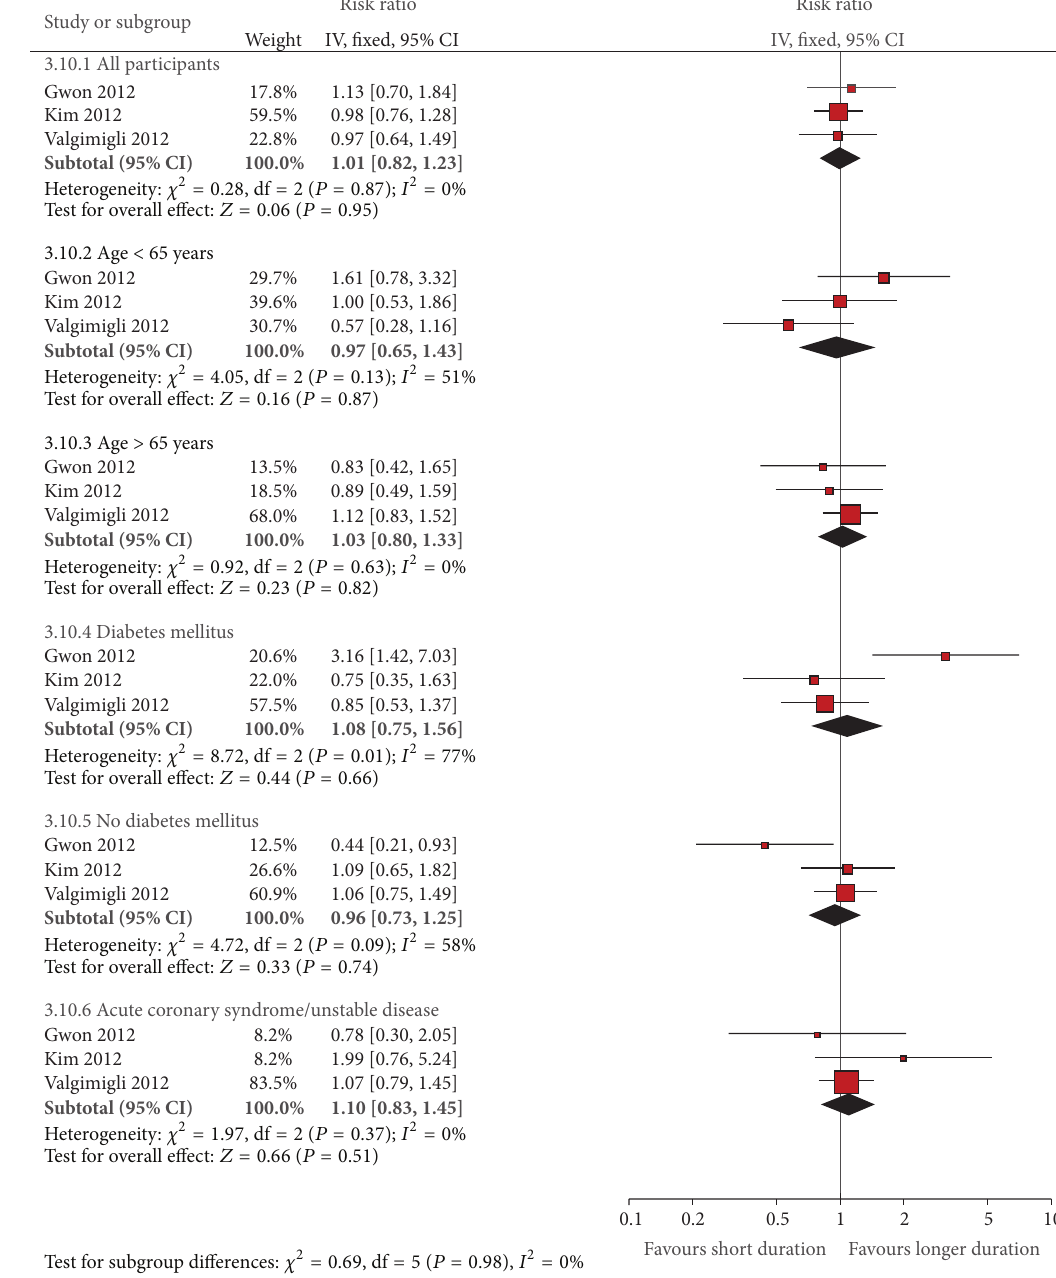
Figure 5: Risk of adverse primary outcomes in specific